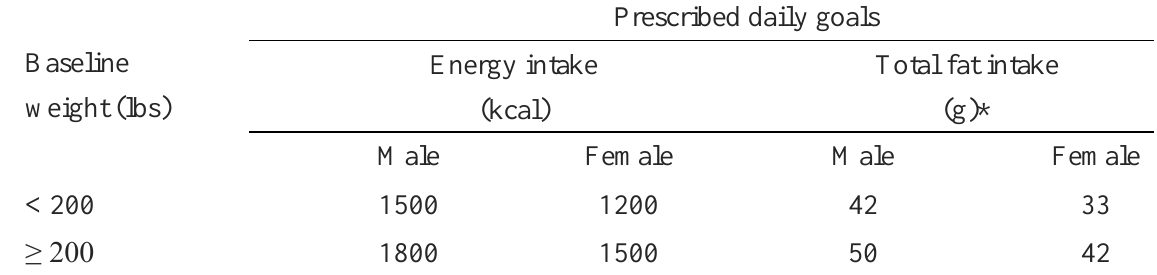
Table 1. Daily dietary